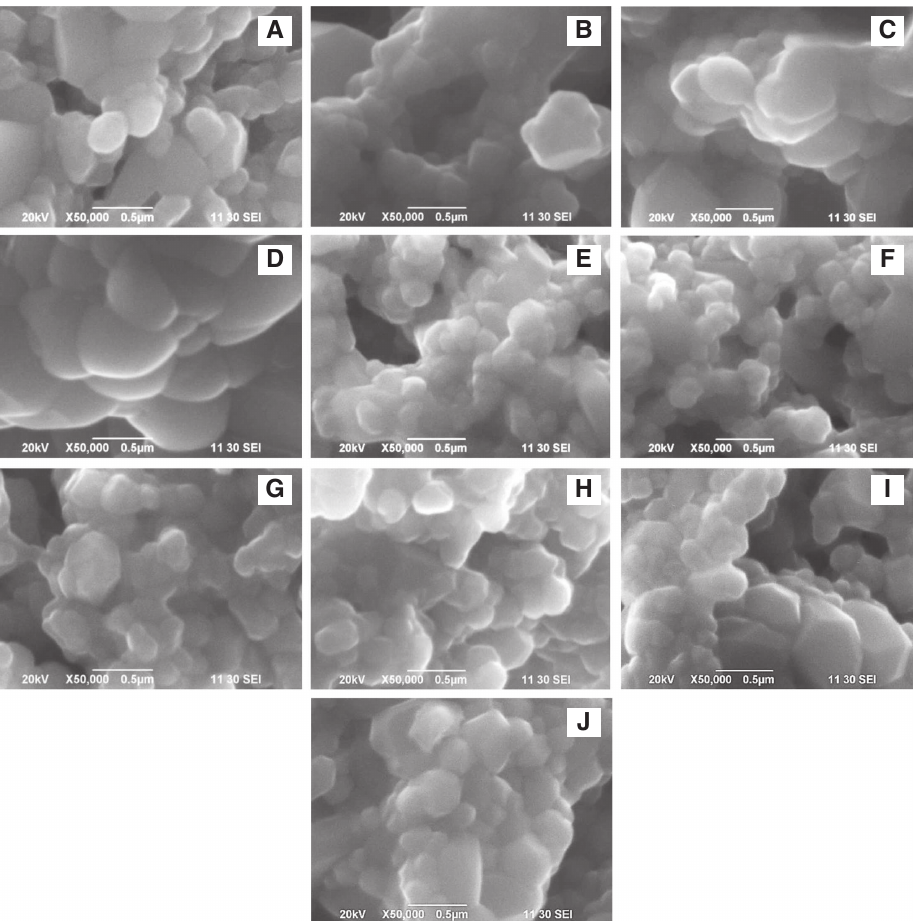
Figure 1: SEM images of the Ba 1 − x Ce x Mn y Ti 1 − y O 3 for x, y = (A) 0.00, 0.00, (B) 0.01, 0.00, (C) 0.02, 0.00, (D) 0.03, 0.0, (E) 0.00, 0.01, (F) 0.00, 0.02, (G) 0.00, 0.03, (H) 0.01, 0.01, (I) 0.02, 0.02, and (J) 0.03,